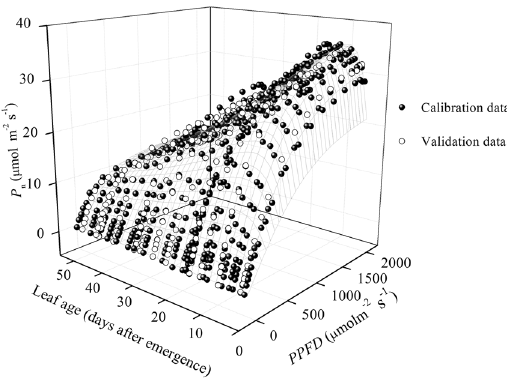
Figure 7. Net photosynthetic rates ( P n ) estimated by the general non-rectangular hyperbola (NRH) equation for rice leaves at various ages under different photosynthetic photon flux density ( PPFD )